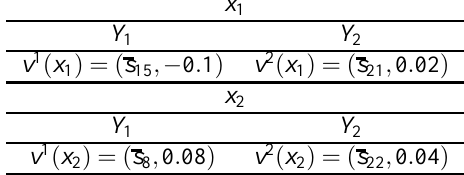
Table 9. Global criteria values for each employee v k ( x j )